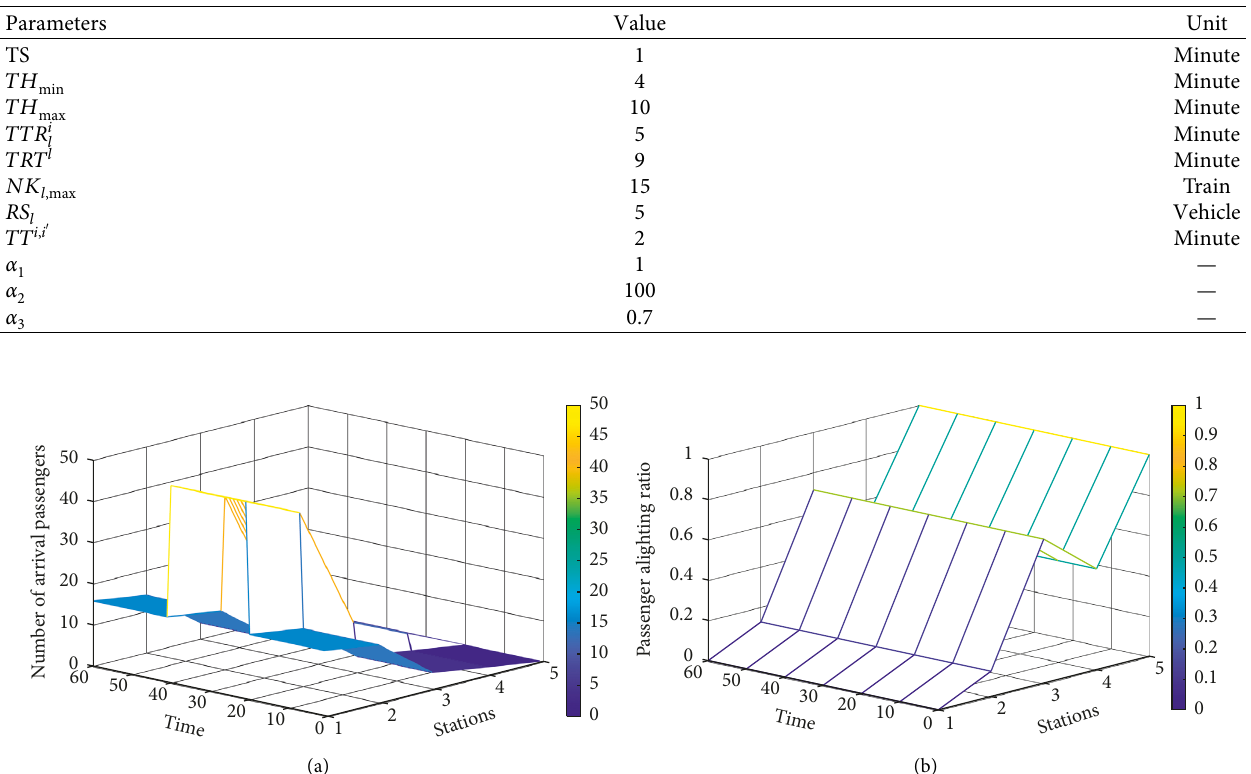
Table 11: The values of numerical case train operation parameters.